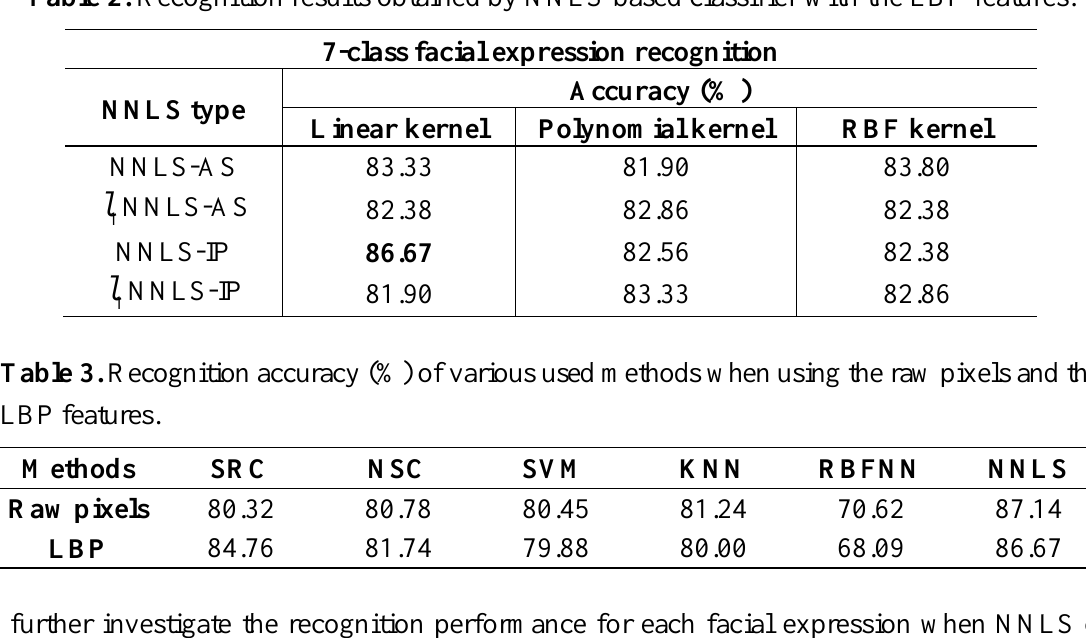
Table 2. Recognition results obtained by NNLS-based classifier with the LBP features.